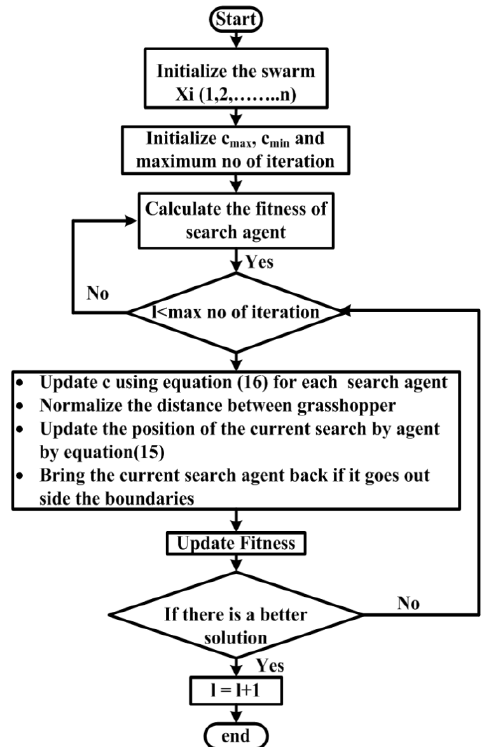
Figure 3. (c) Flowchart of grass hopper algorithm